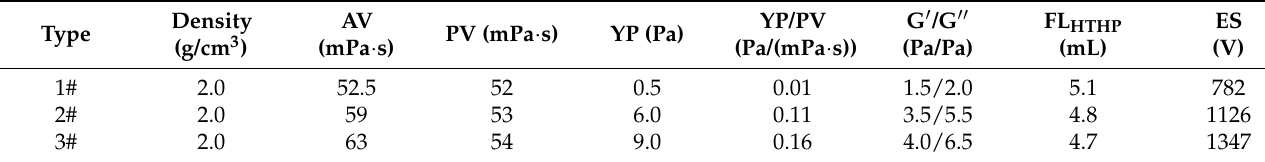
Table 1. The effect of TQ-1 on the performance of OBDFs.